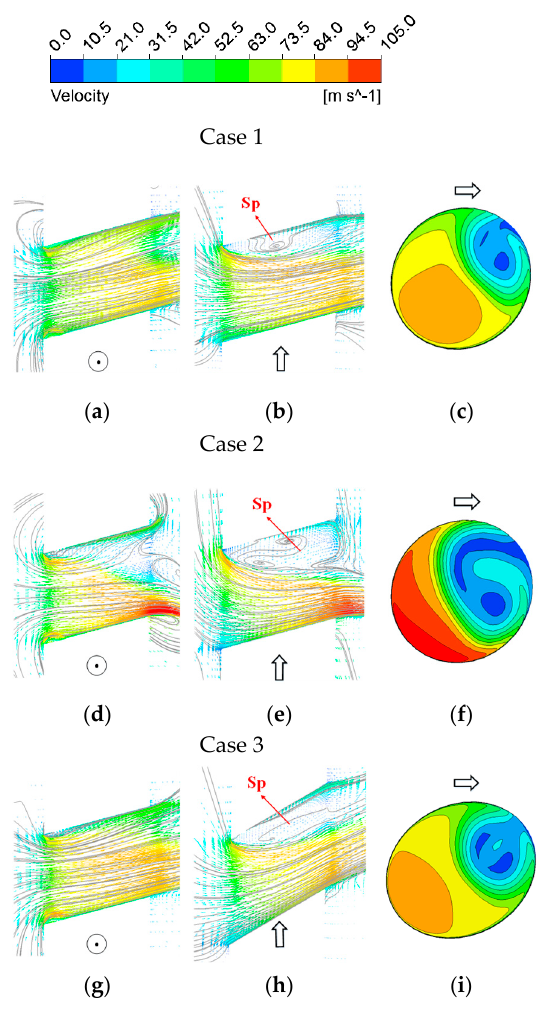
Figure 28. Streamlines and velocity contours under the condition of same 𝛼 (cid:2868) and different 𝛽 (cid:2868) . ( a – c ) 𝛼 (cid:2868) = 15°, 𝛽 (cid:2868) = 15°, N = − 1000 r/min, i = − 24°, 𝐶 (cid:2914) = 0.696; ( d – f ) 𝛼 (cid:2868) = 15°, 𝛽 (cid:2868) = 15°, N = − 3000 r/min, i = − 37.5°, 𝐶 (cid:2914) = 0.528; ( g – i ) 𝛼 (cid:2868) = 15°, 𝛽 (cid:2868) = 30°, N = − 1000 r/min, i = − 38.2°, 𝐶 (cid:2914) = 0.658. ( a , d , g ) Merid-